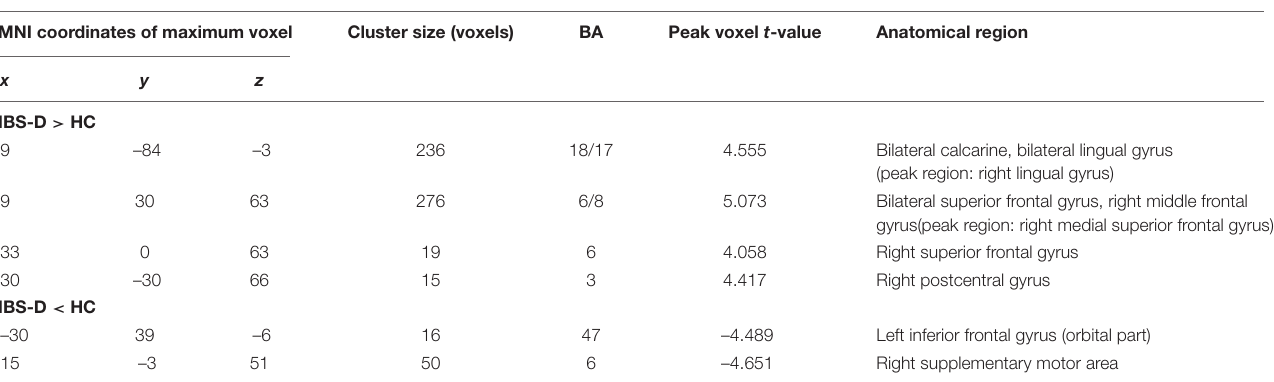
FIGURE 2 | Clusters showing ReHo changes in IBS-D patients as compared to that in healthy controls (TFCE, FWE-corrected P < 0.05). Blue color denotes relatively lower ReHo values in IBS-D group, red color denotes relatively higher ReHo values in IBS-D group, and the color bar in dicates the t -value from two-sample t -test between IBS-D group and HCs. L, left; R, right. TABLE 3 | Brain regions with abnormal ReHo in IBS-D patients compared to